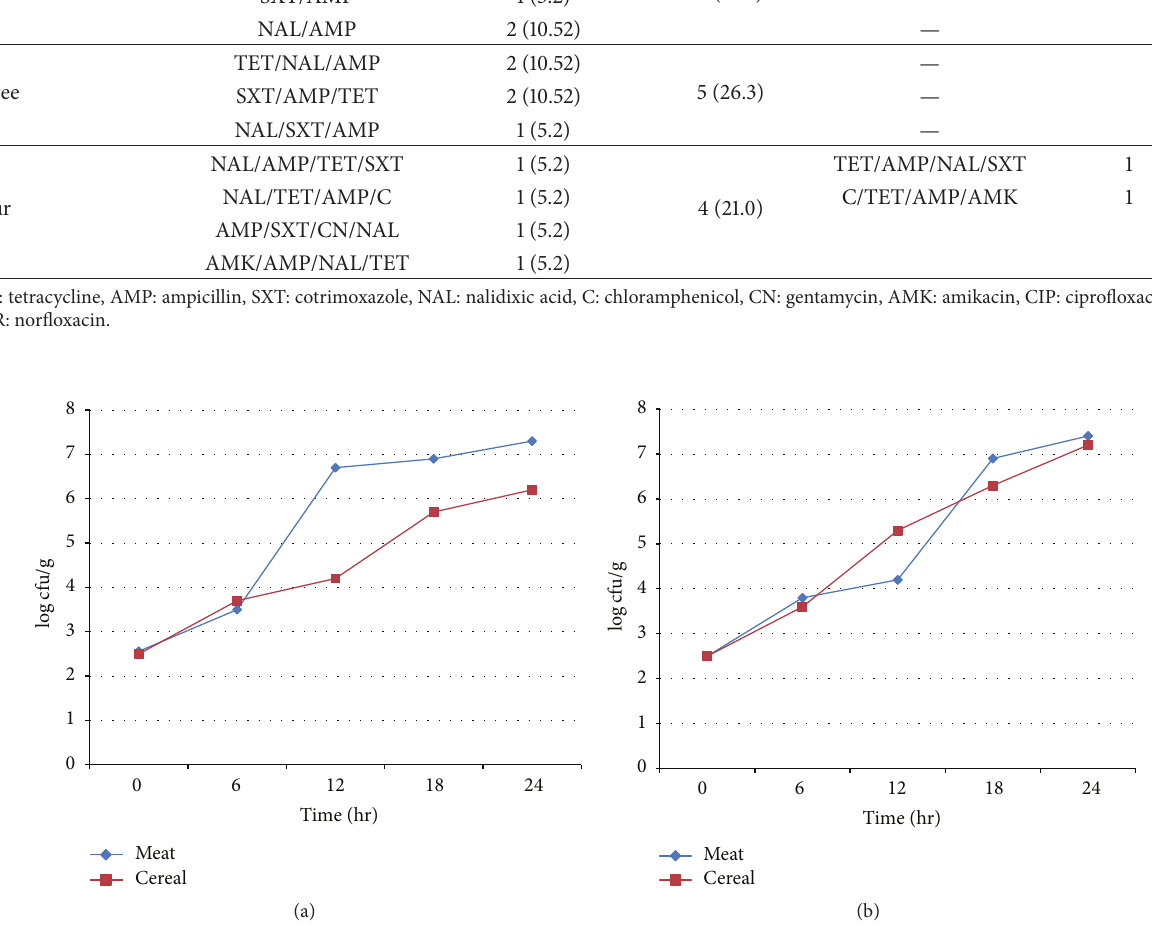
Figure 1: Growth potential of species of Salmonella (a) and Shigella (b) isolated from diarrheal outpatients on meat and cereal products (Jimma University Specialized Hospital,